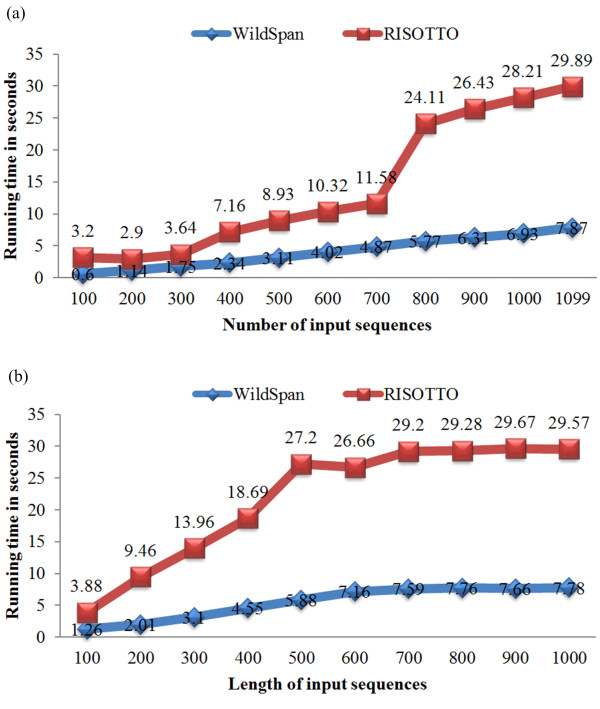
Study of scalibility of WildSpan. Study on the effect of varying the number and sequence length of input sequences of input sequences fed to WildSpan based on the largest dataset (PS00301) of PA10F. (a) Analysis of varying the number. (b) Analysis of varying length of input sequences fed to WildSpan.